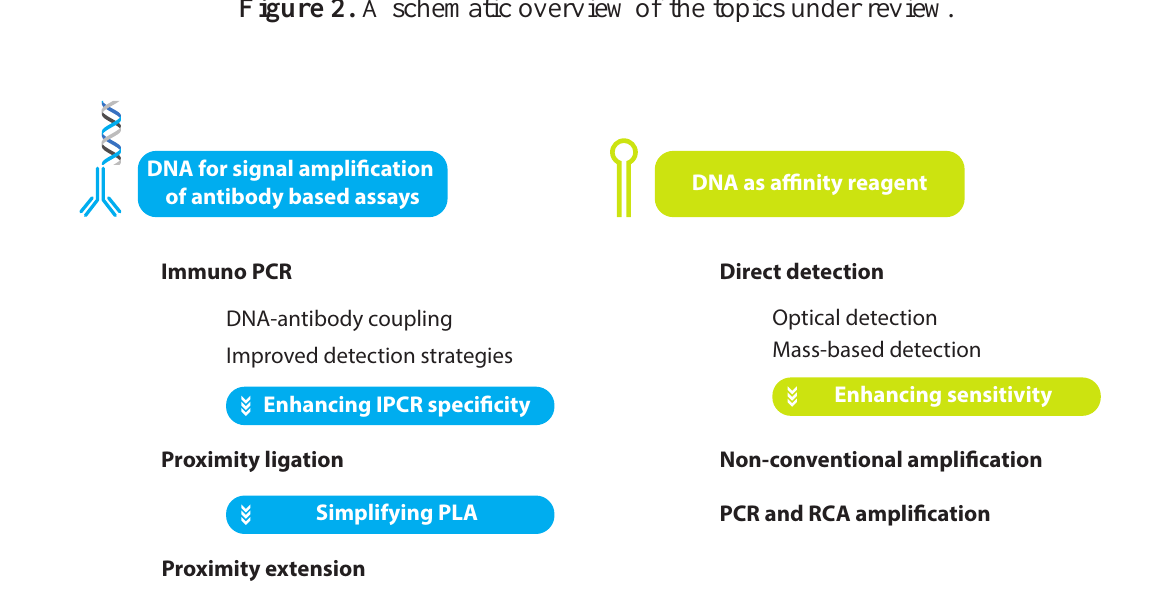
Figure 2. A schematic overview of the topics under